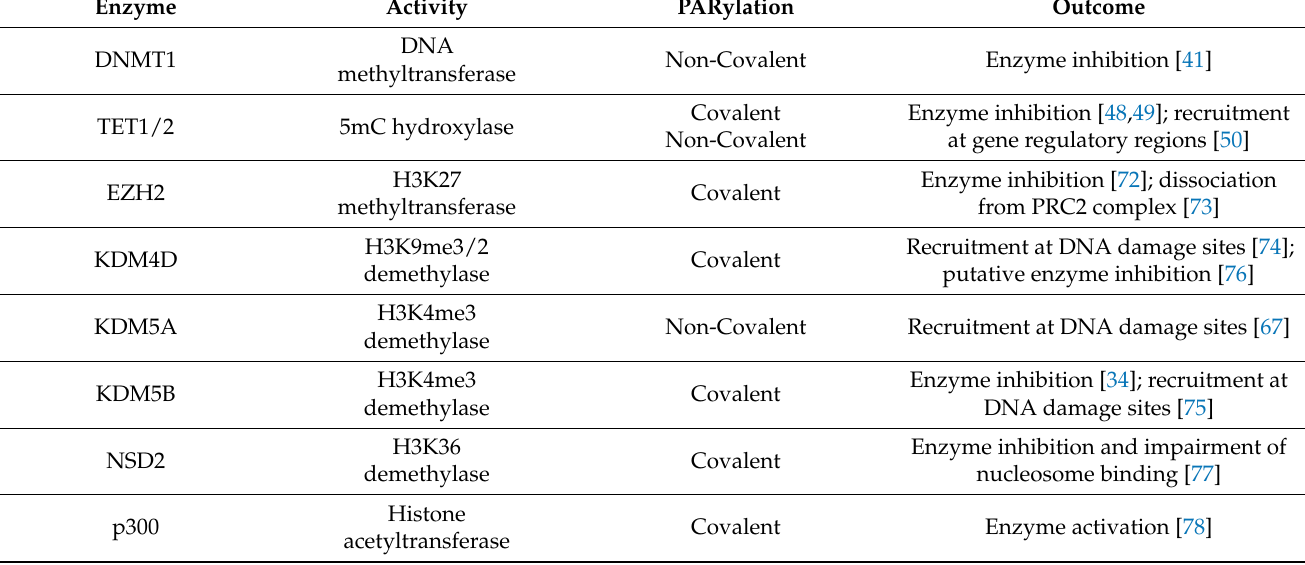
Table 1. Epigenetic enzymes targeted by covalent or non-covalent PARylation.